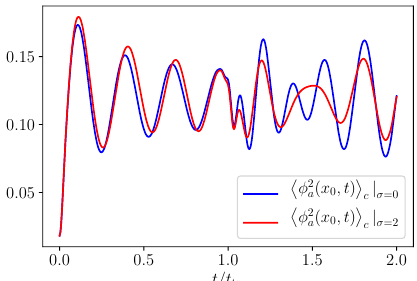
, where a , s = L / 2. 0